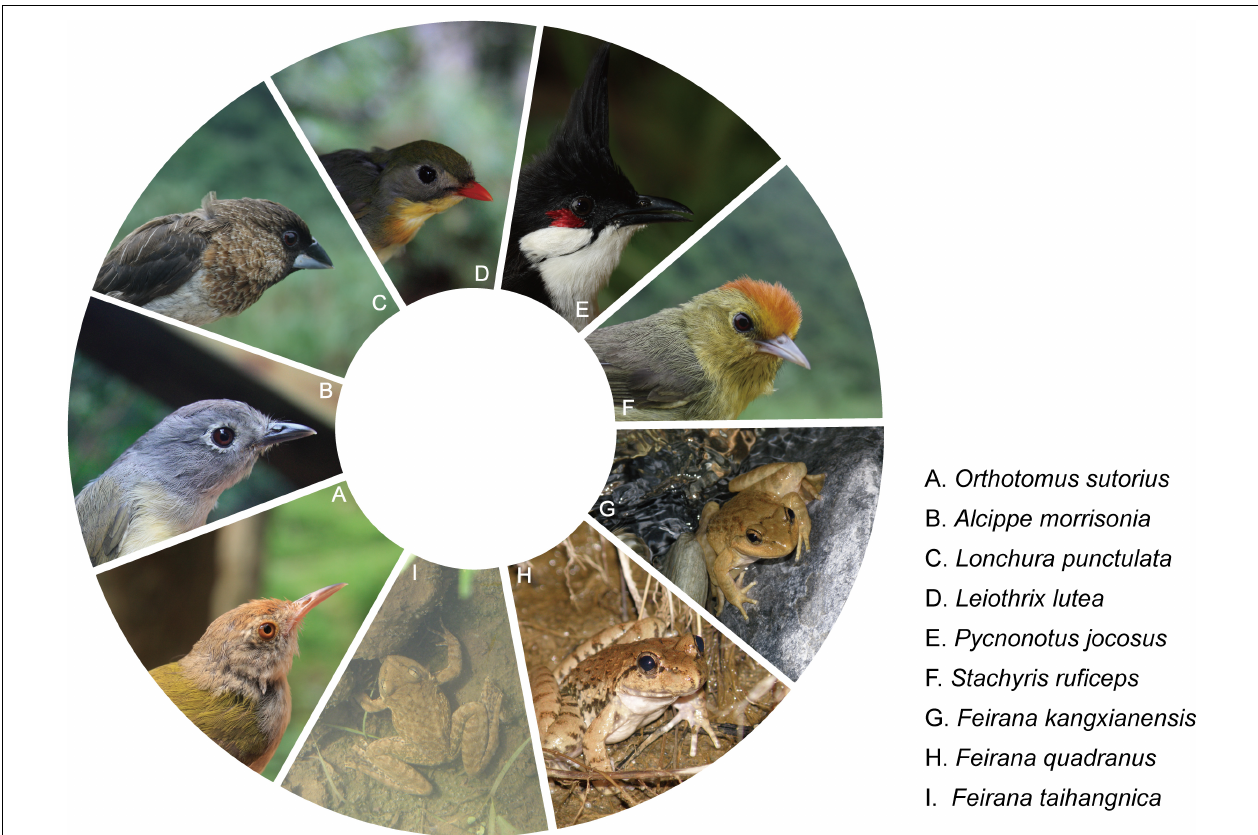
FIGURE 3 | Study species including six common passerines from southwest China (Common Tailorbird Orthotomus sutorius , Gray-checked Fulvetta Alcippe morrisonia , Scaly-breasted Munia Lonchura punctulata , Red-billed Leiothrix Leiothrix lutea , Red-whiskered Bulbul Pycnonotus jocosus , and Rufous-capped Babbler Stachyris ruficeps ) and three frog species from northwest China (Kangxian Swelled-vented Frog Feirana kangxianensis , Swelled-vented Frog F. quadranus and Taihangshan Swelled-vented Frog F. taihangnica